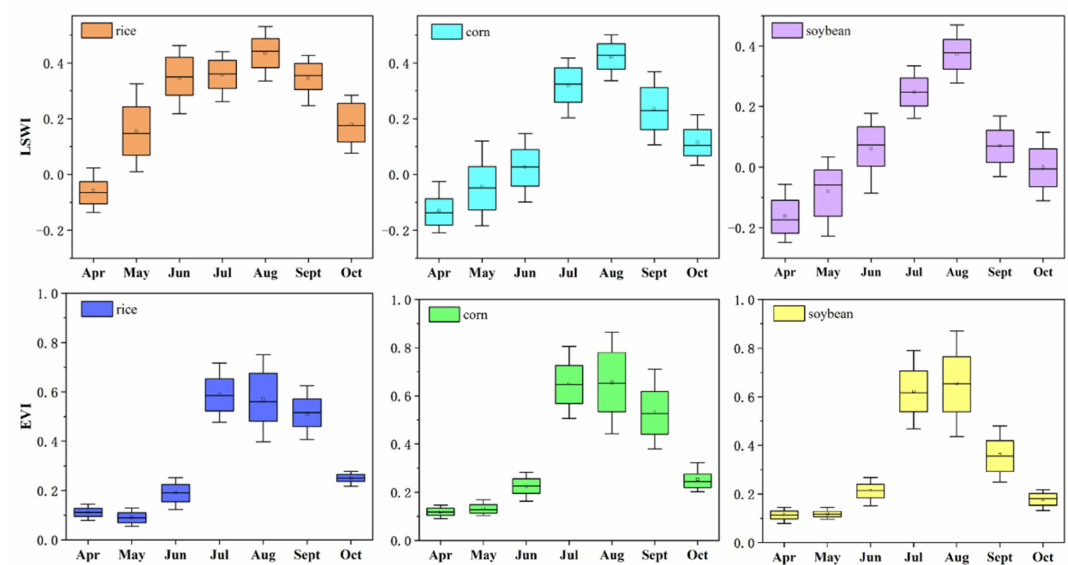
Figure 11. Time series vegetation index characteristics of rice, corn and